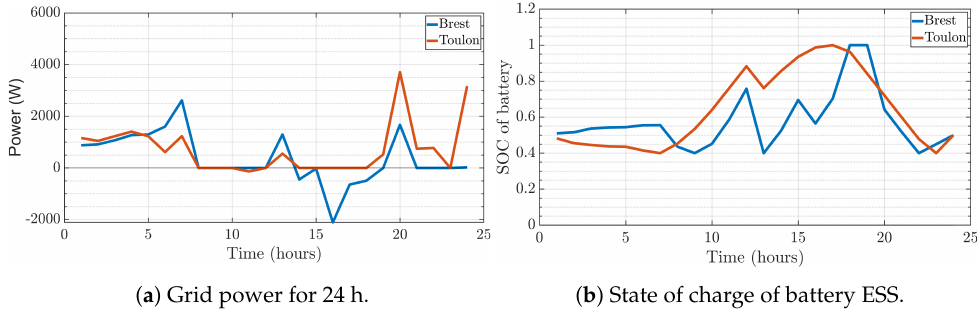
Figure 8. Case study 1: Grid power and state of charge of the battery for Brest and Toulon. Table 4. Case study 1: Energy cost and autonomy achieved without